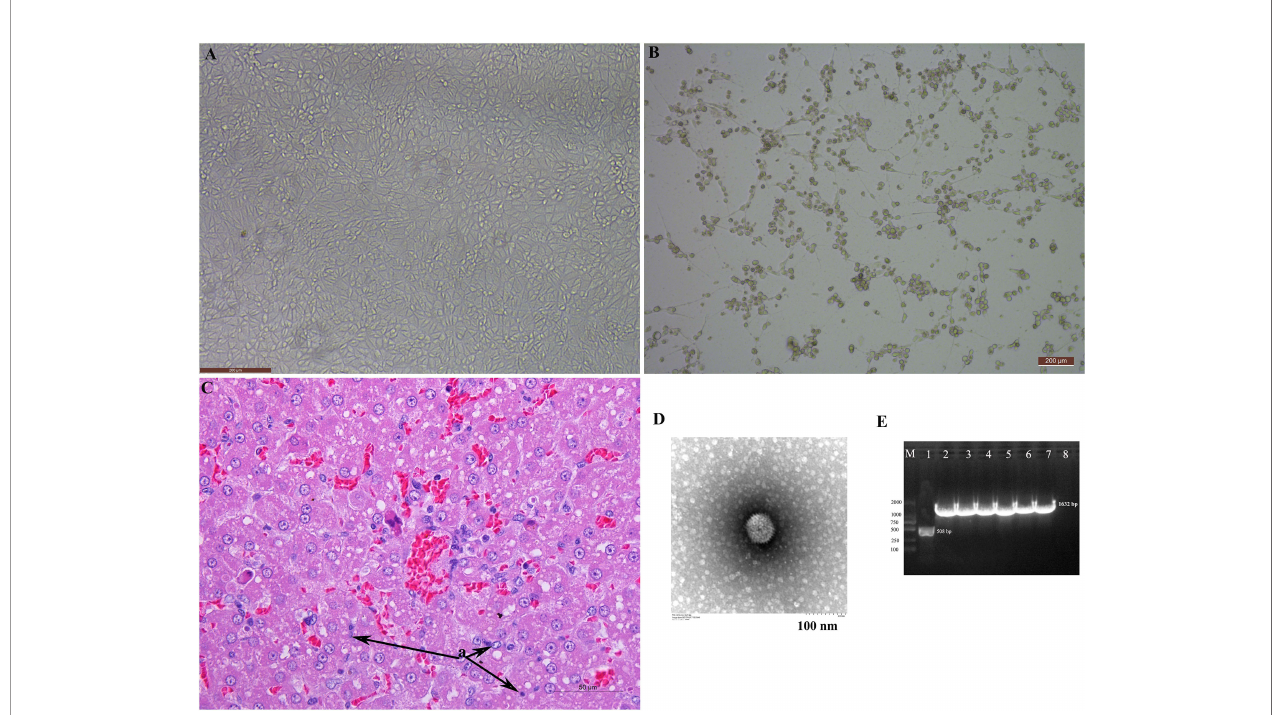
FIGURE 1 | The isolation and identi fi cation of the canine adenovirus 1. (A) Normal MDCK; (B) MDCK with CPE; (C) HE staining of liver; (D) Electron microscopy observation of the adenovirus particles; (E) Ampli fi cation of the Fiber gene and identi fi cation of